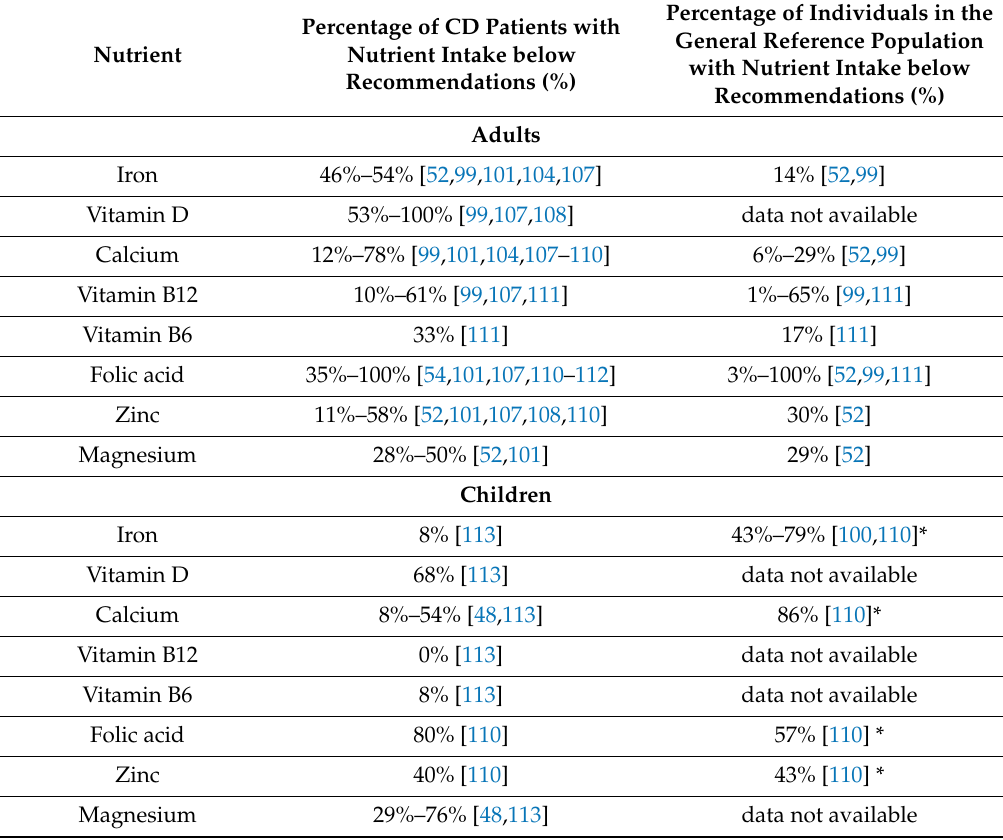
Table 2. Overview of dietary intake of nutrients on a gluten-free diet in celiac disease patients and reference